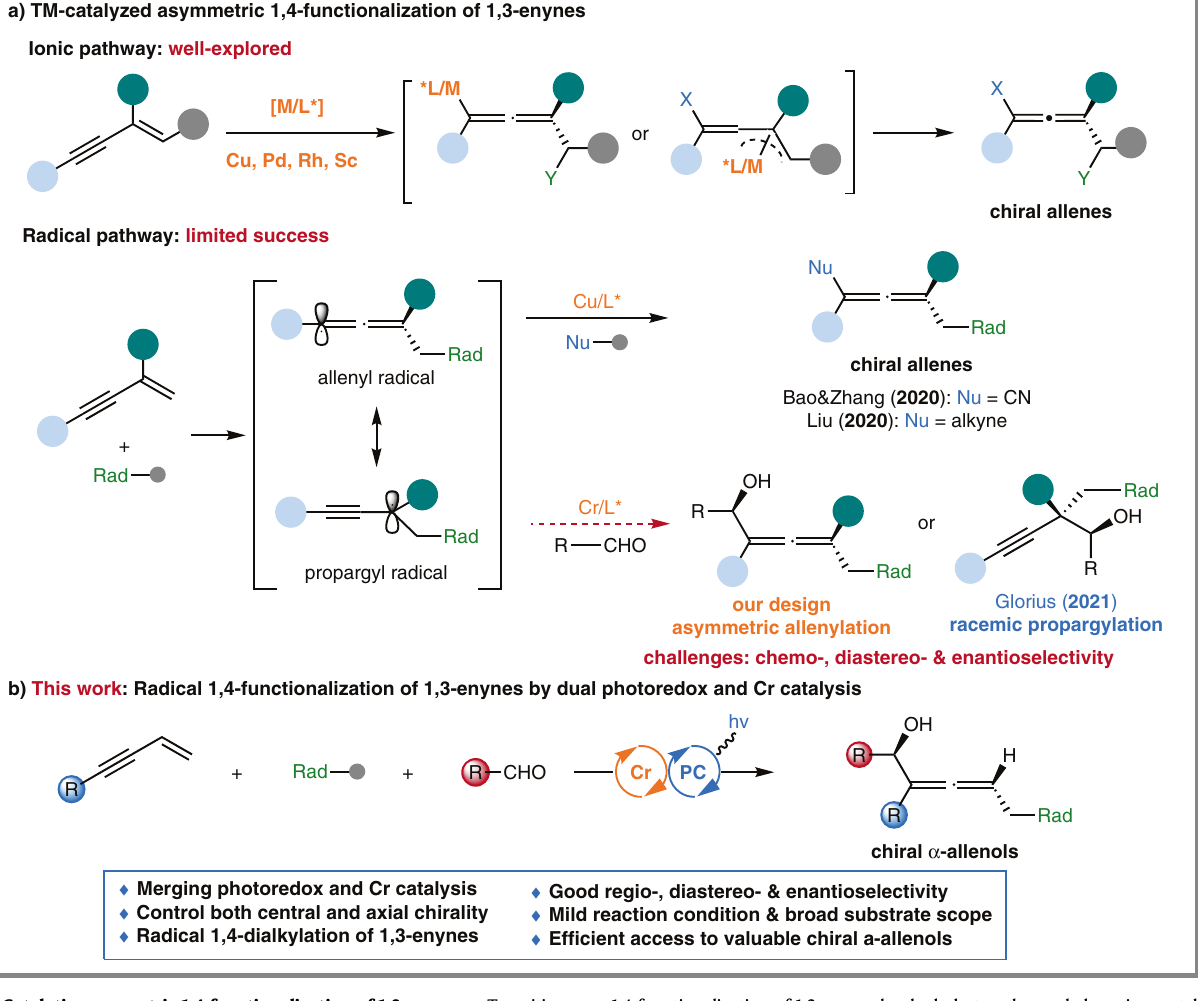
Fig. 1 | Catalytic asymmetric 1,4-functionalization of 1,3-enynes. a Transition- metalcatalyzedasymmetric1,4-functionalizationof1,3-enynes. b